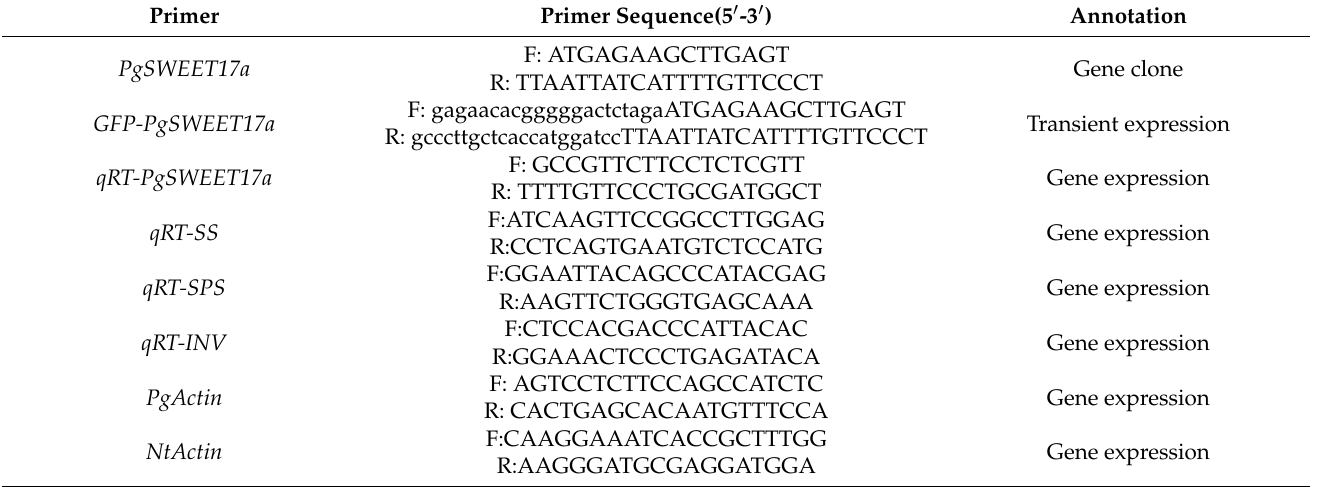
Table 5. Primers for the gene cloning, transient expression and